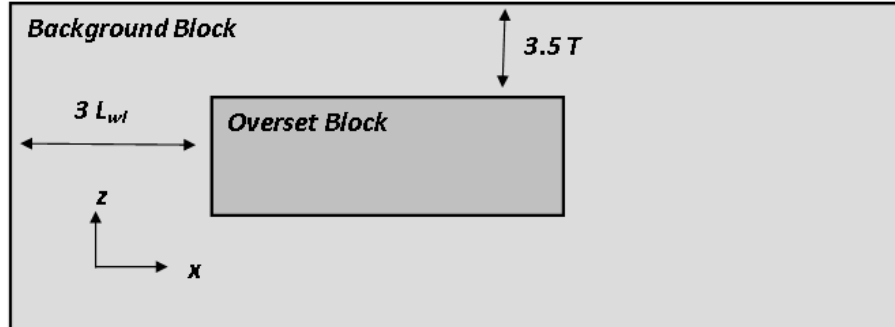
Figure 4. Overset and Background regions.